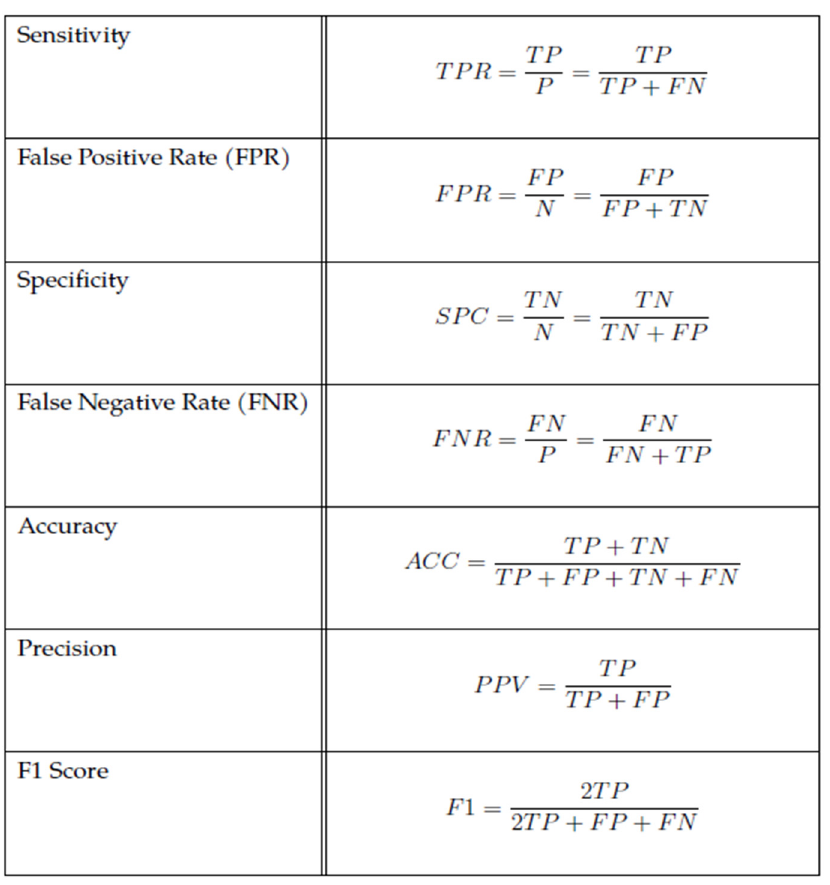
Figure 6. Formulas of the used measures of the effectivity of models.